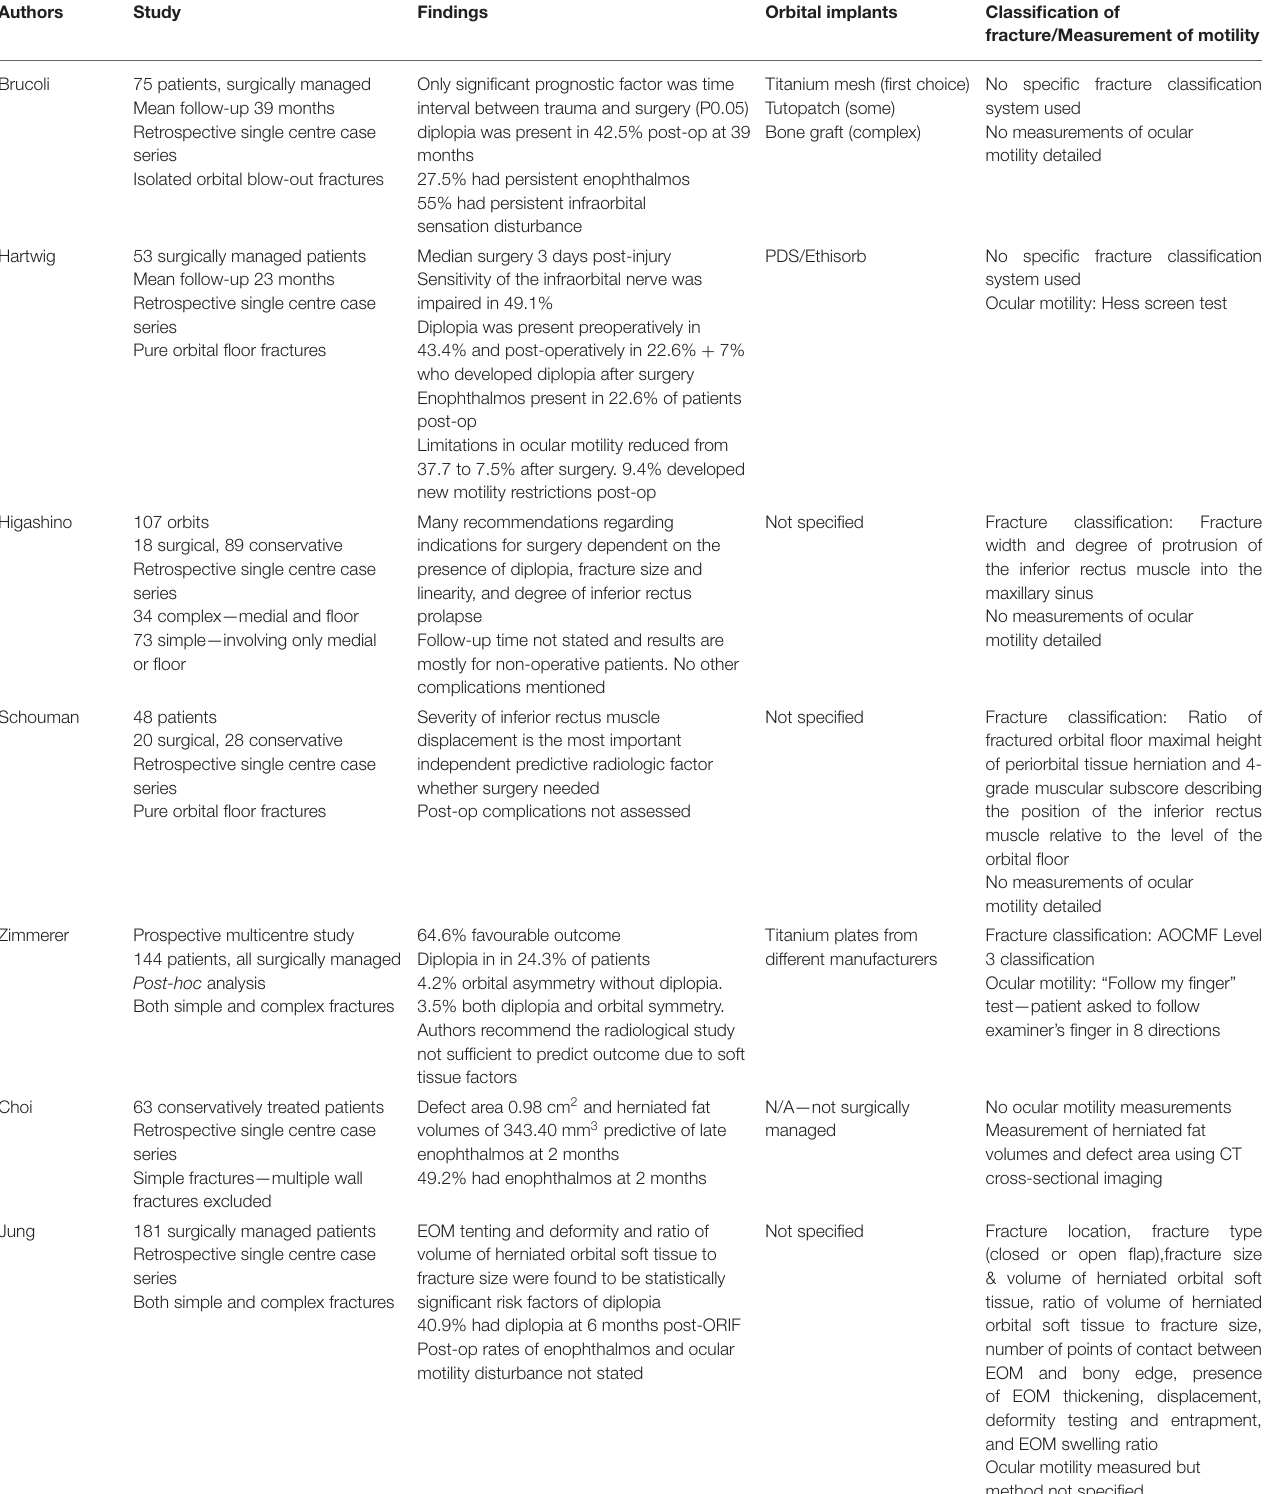
TABLE 5 | Summary of orbital fracture repair studies and